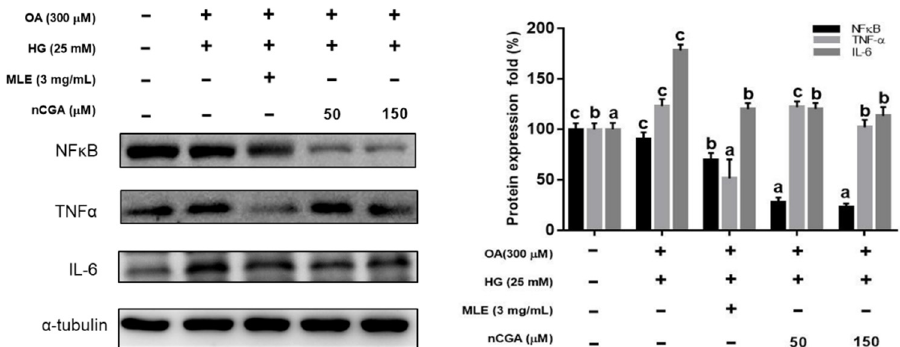
Figure 5. MLE and nCGA reduced inflammatory protein expressions in OH − induced HepG2 cells. HepG2 cells were co-treated with OH, MLE (3 mg/mL), and nCGA (50 or 150 μ M) at 37 °C for 24 h. Protein extracts from the HepG2 cells were measured by Western blotting to detect TNF- α , NF- κ B, and IL-6; α -tubulin was used as a loading control. Values are the mean ± SD of three independent experiments. Data were represented using one-way ANOVA, followed by Duncan’s new multiple range test. Quantitative bars not sharing a common letter are significantly different ( p < 0.05) from each other.